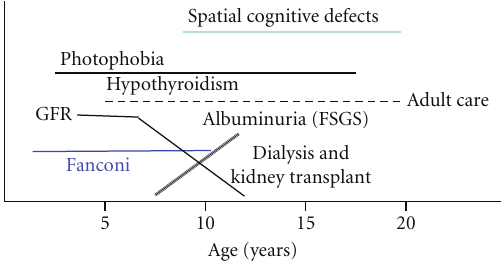
Figure 5: Natural history of untreated